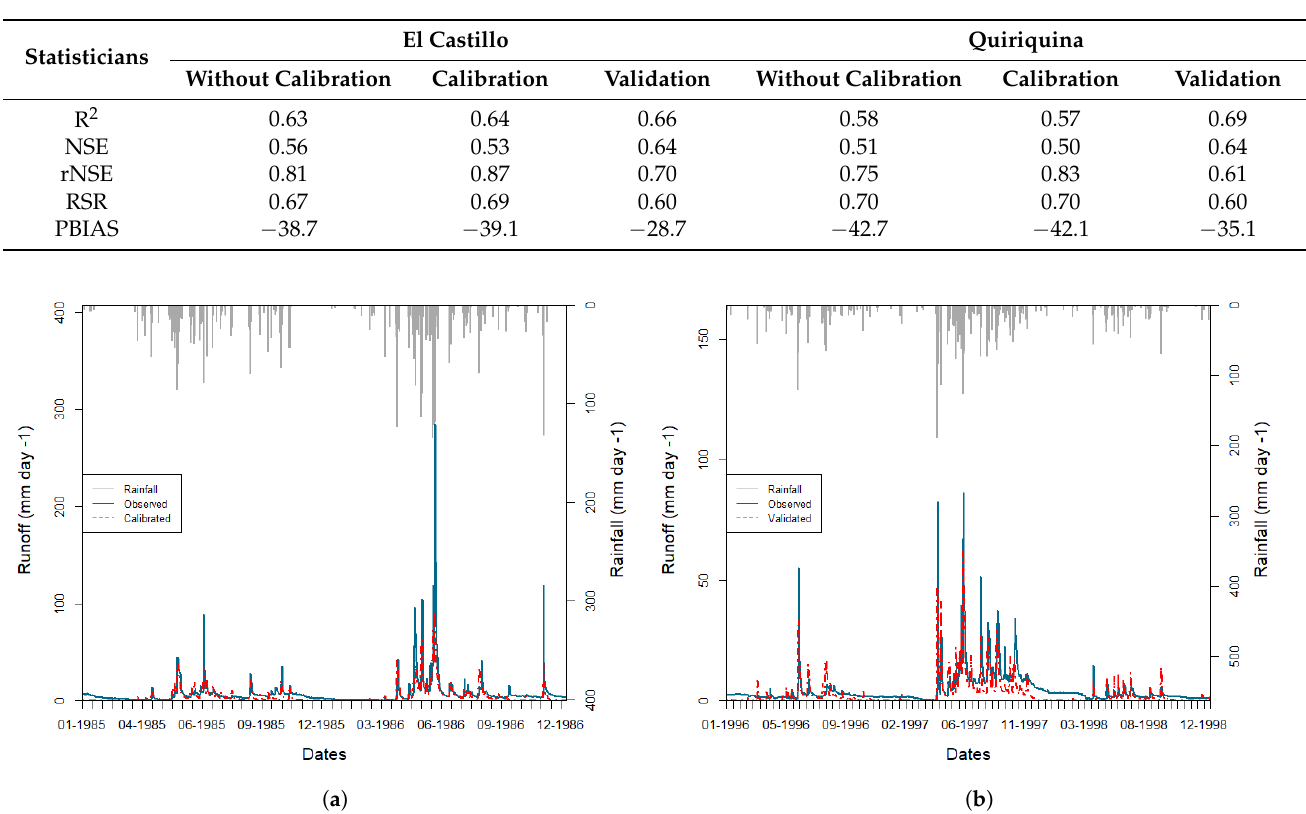
Table 6. Efficiency criteria for the period without calibration and calibration (1985–1986) and for the validation period (1996–1998) at daily time step for El Castillo and Quiriquina stations.